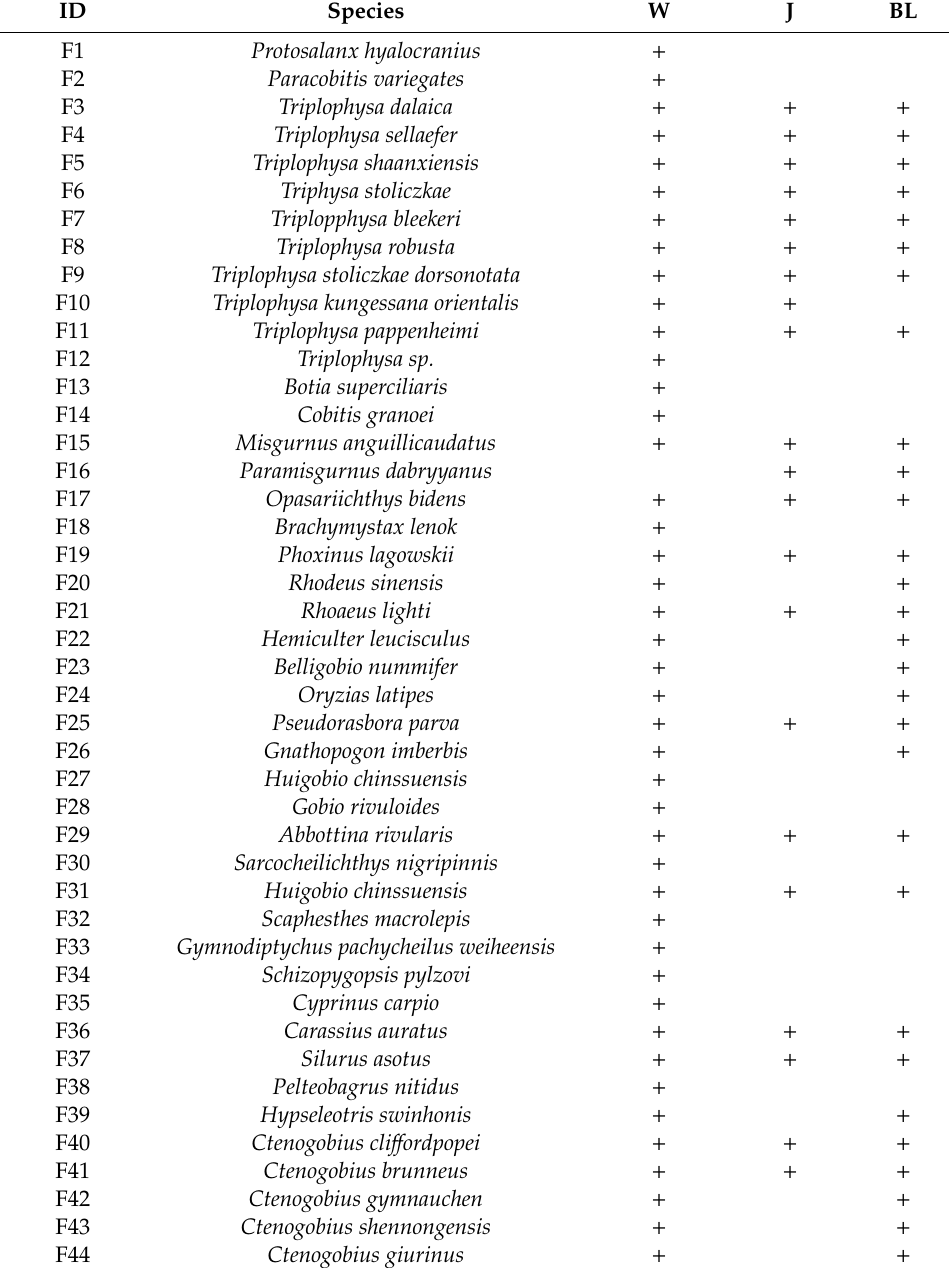
Table A3. The list of fish species in Wei River